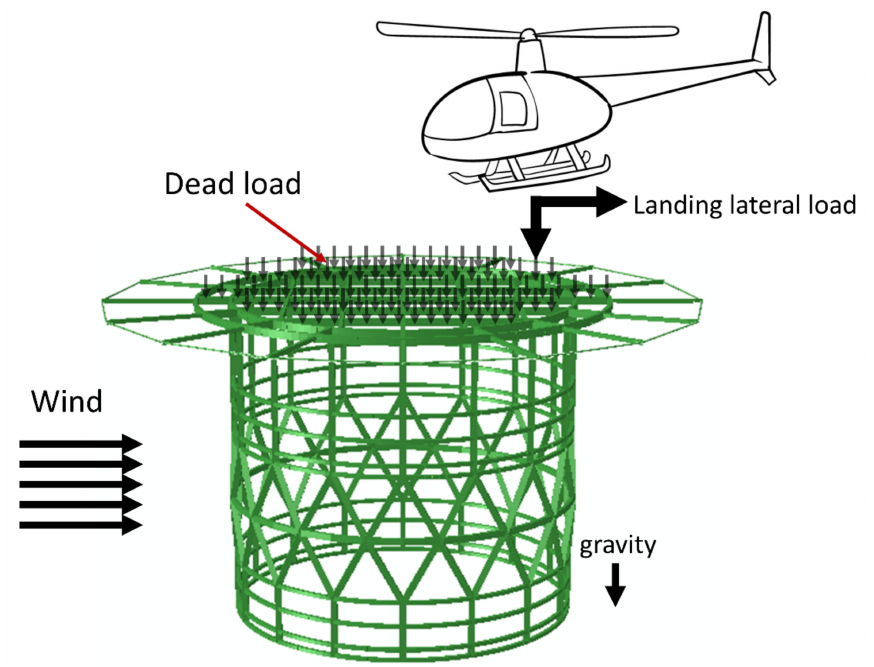
Figure 10. Applied loads shown on the current helideck structure on Bishop Rock lighthouse according to CAP 437 for edge landing scenario (all vertical posts at the bottom of the structure are anchored to the top of the lighthouse). According to the standard, the wind load and landing lateral loads are considered in the same direction to produce the worst